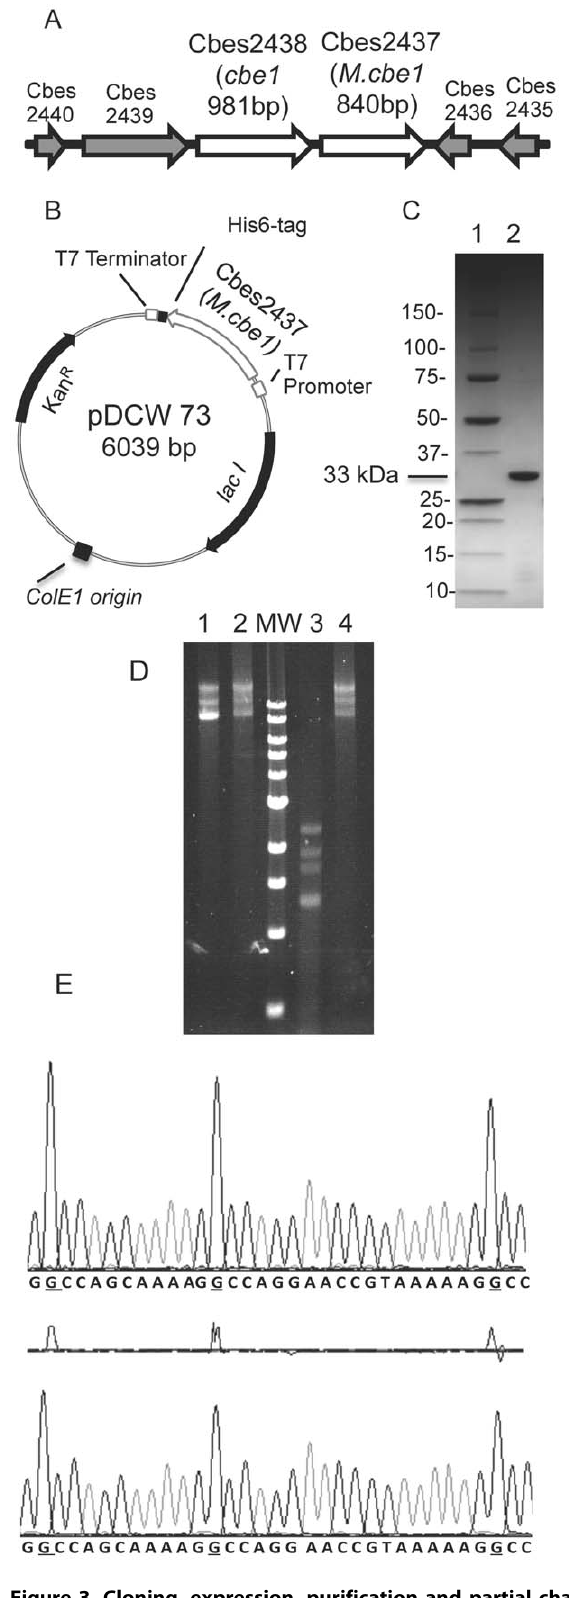
Figure 3. Cloning, expression, purification and partial charac- terization of M.CbeI. (A) The region of the C. bescii chromosome containing CbeI and M.CbeI. (B) Diagram of pDCW73 used to produce a His-tagged version of M.CbeI in E. coli . (C) Purified M.CbeI